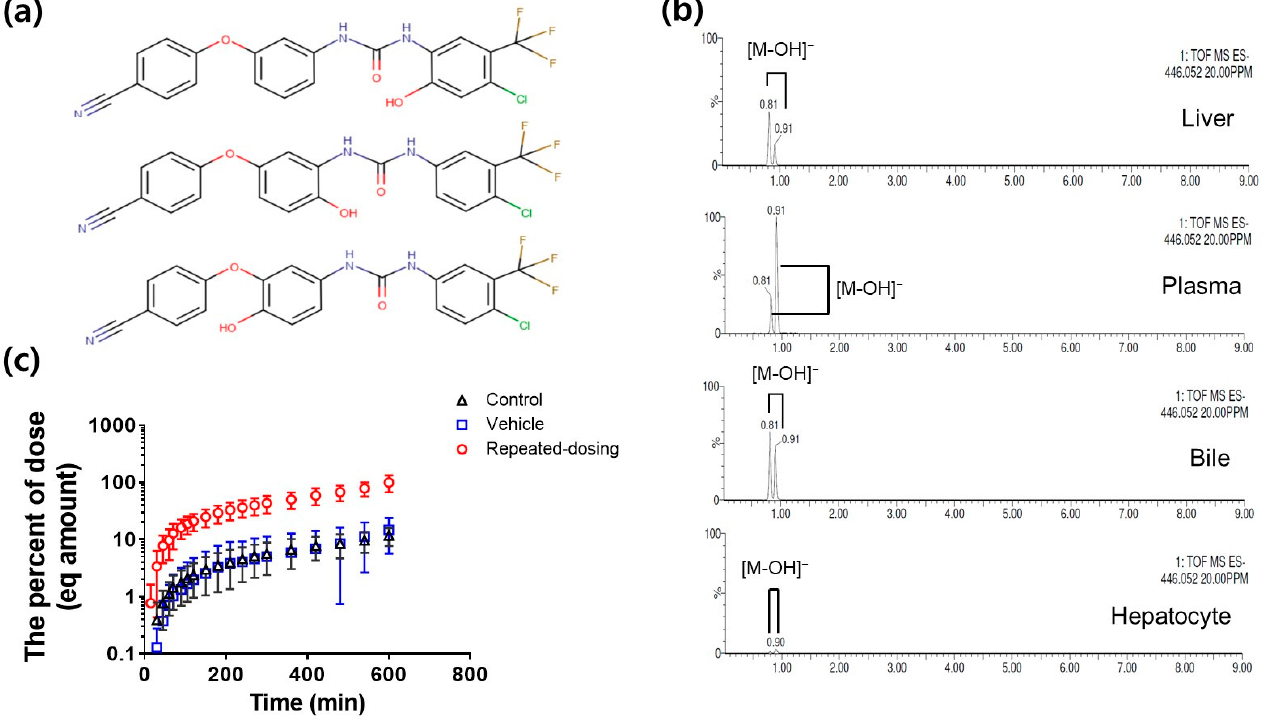
Figure 4. ( a ) Three candidate metabolites of the SCR430 aromatic hydroxyl site via CYP-mediated metabolism predicted by metabolite profiling. ( b ) Representative UPLC-qToF-MS chromatograms for the two hydroxylated SCR430 metabolite types in the liver tissue, plasma, bile, and hepatocytes of the repeated-dosing group. ( c ) The equivalent cumulative percentage–time profile of the dose recovered as an aromatic hydroxylated metabolite in the bile after IV administration among the control, vehicle, and repeated-dosing groups. (Data = mean ± standard deviation (SD), n = 3).